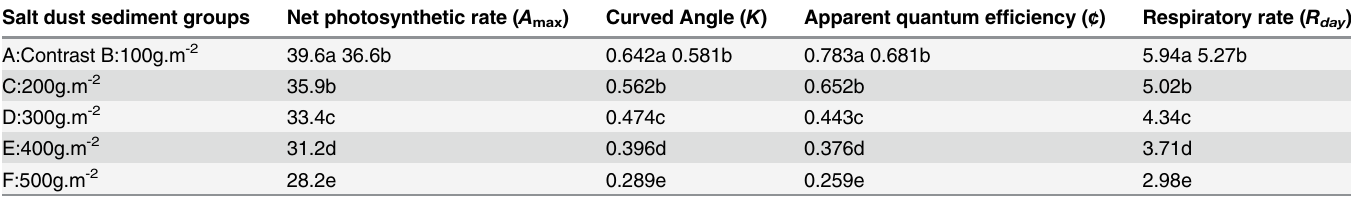
Table 2. The light response model parameters of the cotton